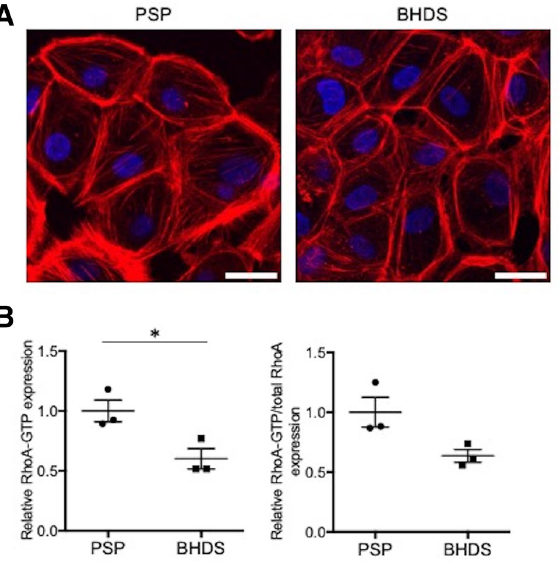
Figure 5. Comparison of F-actin formation and RhoA activity between PSP- and BHDS-PMCs. ( A ) Representative confocal photomicrographs of phalloidin staining in PSP- and BHDS-PMCs (PSP, n = 3; BHDS, n = 3). At passage 1, 3 × 10 5 PMCs were seeded onto a 35 mm glass-bottom dish until the cells became confluent. Scale bars represent 20 μm. ( B ) Plot of the levels of active RhoA-GTP and total RhoA. The vertical axis in the left plot indicates the relative RhoA-GTP expression when normalized by the mean level of RhoA-GTP in PSP- PMCs. At passage 1, 3 × 10 5 PMCs were seeded on a collagen-coated 6-well plate, cultured until approximately 70% confluence, and then utilized for the measurement. The vertical axis in the left panel indicates the relative ratio of RhoA-GTP when normalized by the mean level of RhoA-GTP in PSP-PMCs. The vertical axis in the right plot indicates the relative ratio of RhoA-GTP/total RhoA when normalized by the mean level of RhoA- GTP/total RhoA in PSP-PMCs. The circles and squares indicate the measured values of each sample (PSP, n = 3; BHDS, n = 3) and the central horizontal lines indicate the position of mean values. The data are shown as mean ± SEM. * = p < 0.05 (unpaired t-